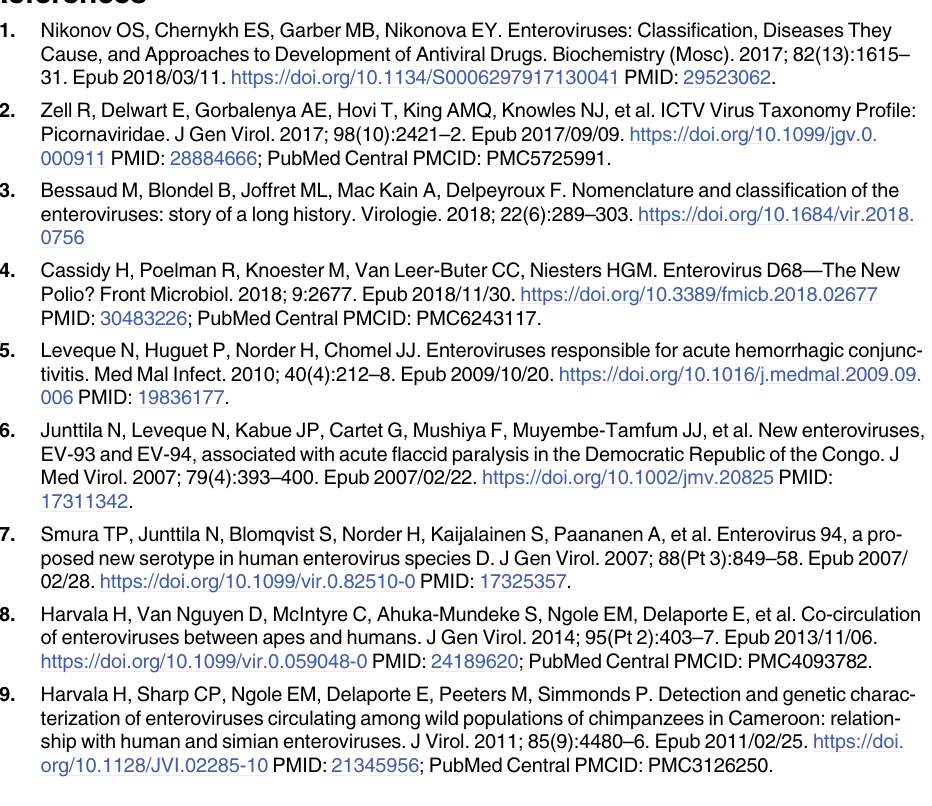
S2 Fig. Immunofluorescence assay with anti-CD155 antibody D171. As expected, fluores- cence was observed on L20B and RD monolayers but not on L cells: L20B and RD cells express CD155 while L cells do